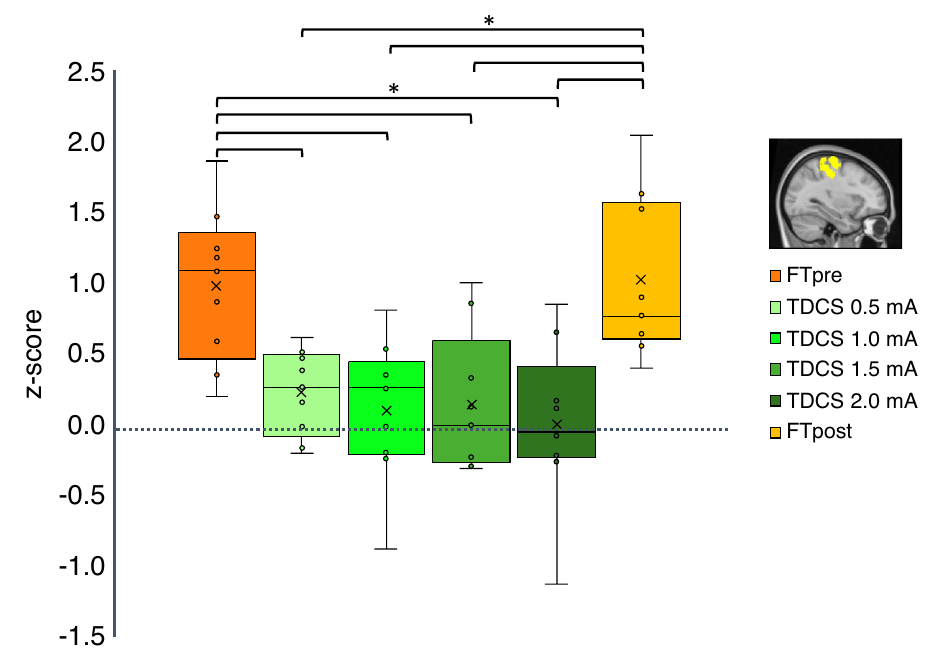
Figure 3. Change in regional cerebral blood flow in left primary sensorimotor cortex. The region is defined using the probabilistic anatomical Juelich atlas. Areas BA4a, BA4b BA3a, BA3b and BA6 for the left hemisphere was used, and the mask was limited in each direction to fit the hand knob. Box and whisker plot of activation during TDCS at 0.5–2.0 mA (green shades) and finger-tapping before stimulation (FTpre) and after (FTpost) (orange shades). Y-axis shows activation in z-score. Outliers defined being beyond 1.5 inter-quartile range of each quartile.